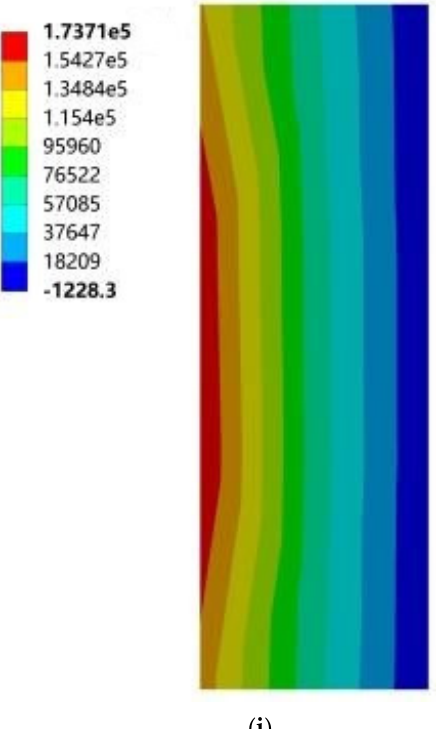
Figure 19. Maximum principal stress cloud diagram of north vertical sun visors. ( a ) South to south- east wind. ( b ) South to northwest wind. ( c ) South by west 15 to southeast wind. ( d ) South by west 15 to northwest wind. ( e ) South by west 30 to southeast wind. ( f ) South by west 30 to northwest wind. ( g ) South by east 15 to southeast wind. ( h ) South by east 15 to northwest wind. ( i ) South by east 30 to southeast wind. ( j ) South by east 30 to northwest wind.